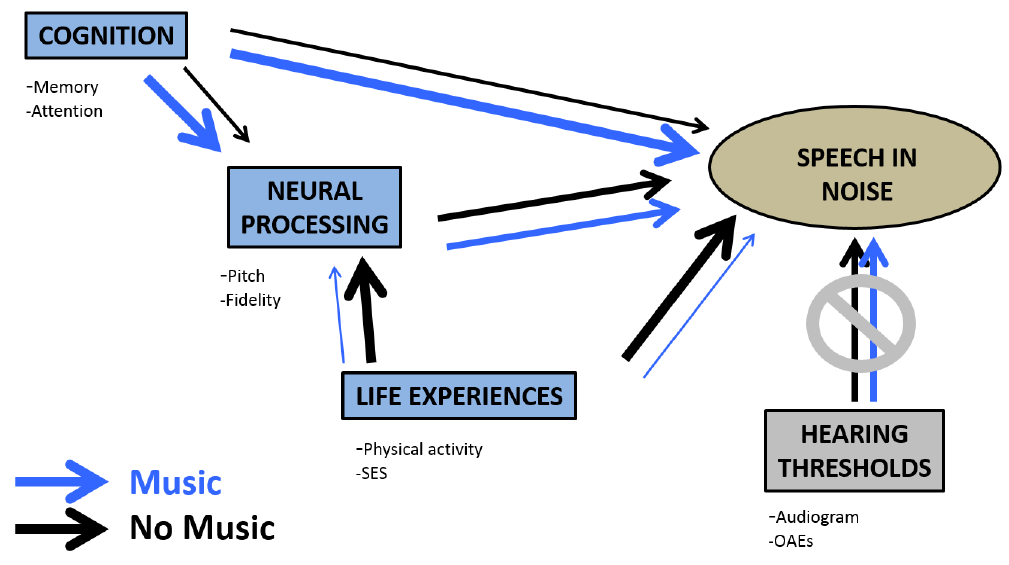
Figure 4. A model of processing speech in noise in middle-age and older adults. The structural equation model [93] includes variables relating to cognition, central auditory processing, musical background, and life experiences ( i.e. , socioeconomic status and fitness level). This model, as schematized here, suggests that the neural networks that contribute to understanding speech in noise differ depending on whether the participant received musical training in their past or not. The group of older adults with past music training ( blue arrows ) was found to rely more on cognitive factors, whereas the group without musical training ( black arrows ) are shown to rely more on other life experiences. For each comparison, the wider arrow refers to the stronger contributor. Modified from Anderson et al. , 2013